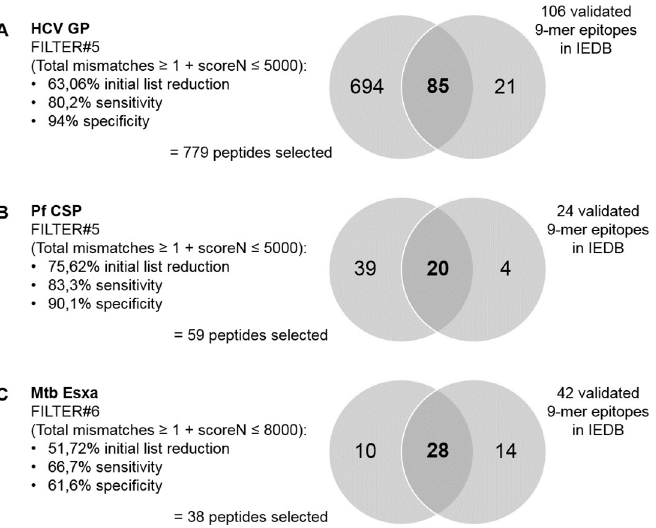
Fig 3. Sensitivity and specificity of example filters applied to final HLA-class I results table from SILVI.